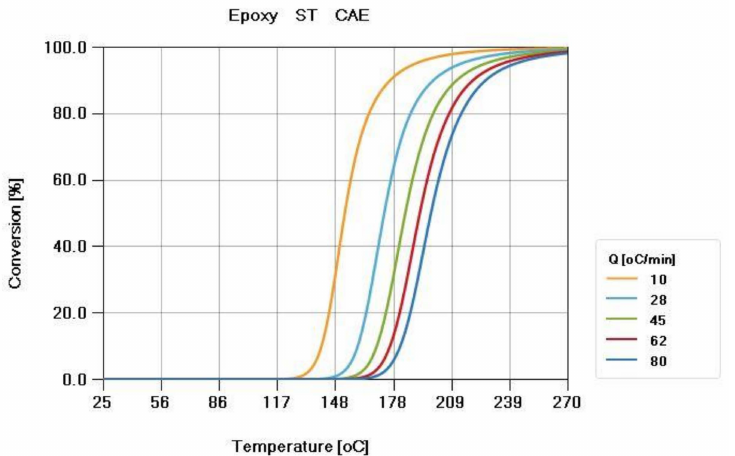
Figure 4. Curing kinetics curve of the ST resin. The curing kinetics is measured by a DSC with different temperature ramping rates (Q = 10, 28, 45, 62, 80 ◦ C/min).